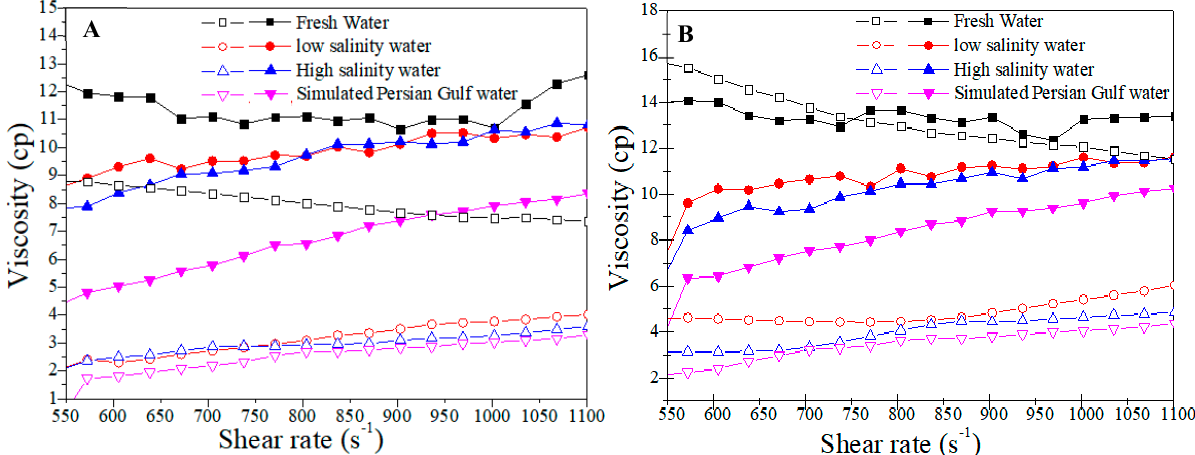
Figure 4. Viscosity vs. shear rate at different salinity for Flopaam 3630S (closed) and B192 (open) polymer solutions at ( A ) 1000 ppm and ( B ) 1500 ppm concentrations.